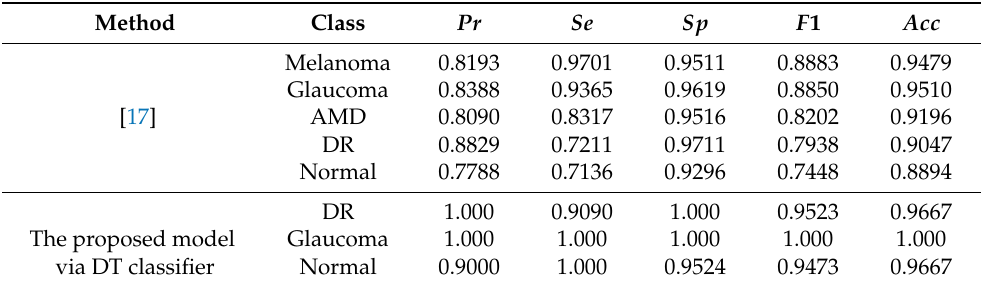
Table 10. Comparison between the results of the proposed model and the state-of-the-art method as an automatic deep feature